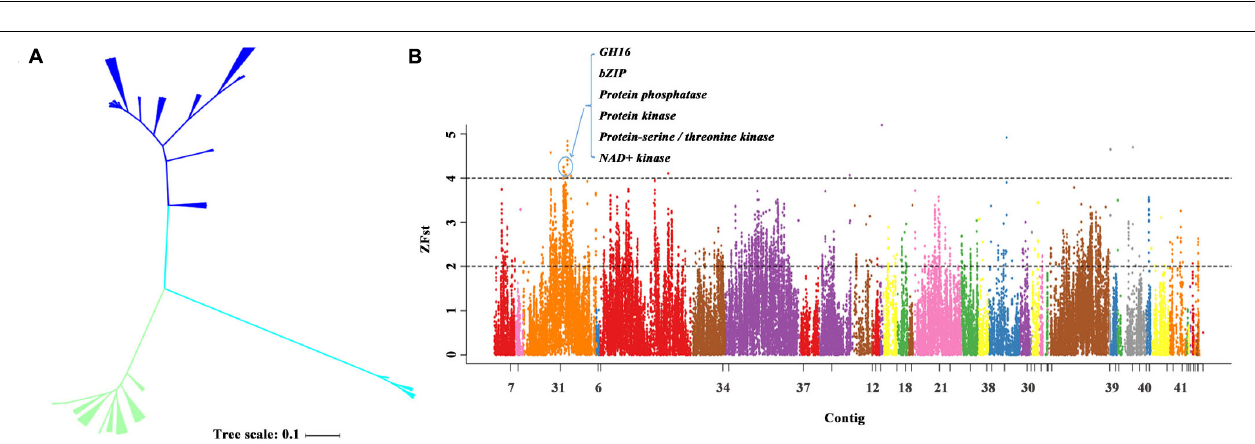
FIGURE 3 | Circos plot of the SNPs and InDels distributions in P. eryngii var. e ryngii and var. ferulae populations. (A) The SNPs and InDels distributions of 19 P. eryngi i var. e ryngii strains using the reference genome PEE81. (B) The SNPs and InDels distributions of 14 P. eryngi i var. ferulae strains using the reference genome PEF12. Outside to inside of concentric circles show assembly scaffold number, SNPS distribution and density, InDels distribution and density (window size = 50 kbp).